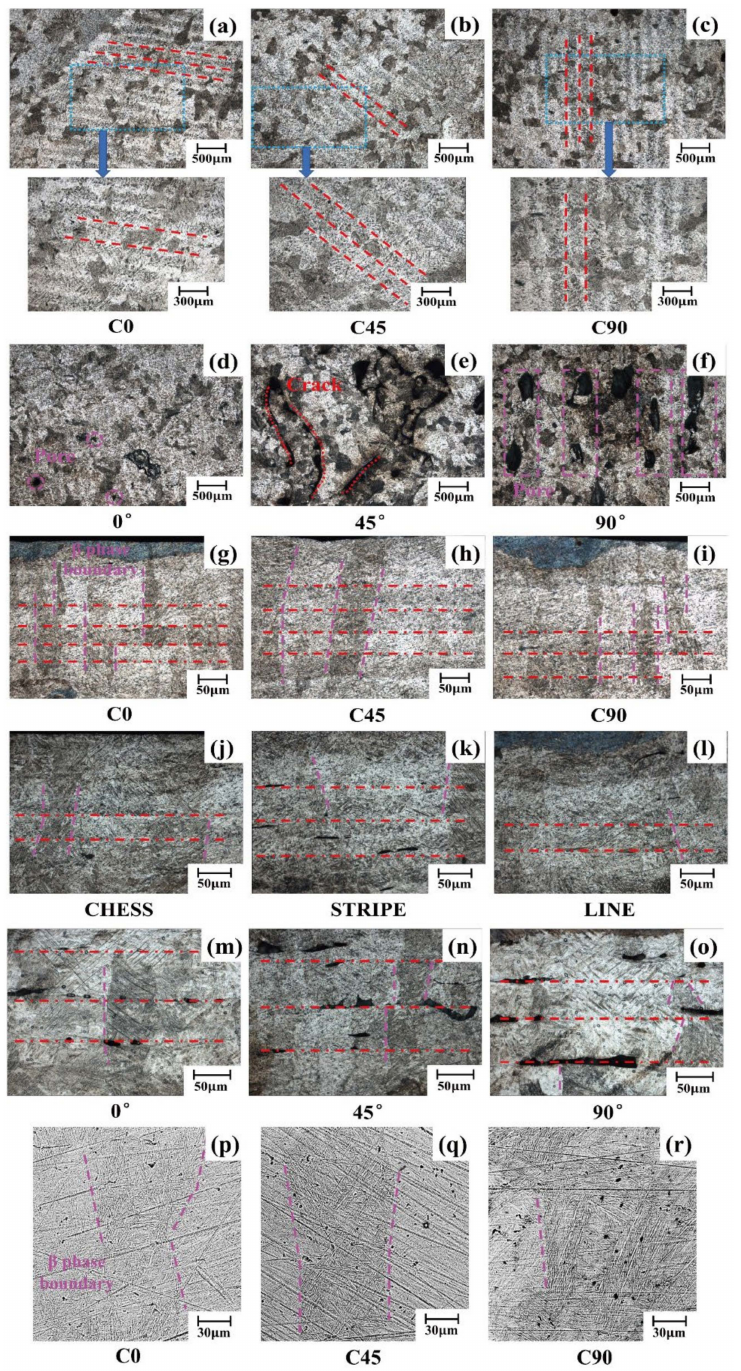
Figure 12. Metallographic structure of L-PBF samples under different combinations of scanning strategies and a single scanning strategy. ( a – f ) Corresponding to the upper-surface metallographic structure of the C0, C45, C90, 0 ◦ , 45 ◦ , and 90 ◦ samples, respectively; ( g – o ) corresponding to the longitudinal-section metallographic structure of C0, C45, C90, CHESS, STRIPE, LINE, 0 ◦ , 45 ◦ , and 90 ◦ samples respectively; ( p – r ) SEM images of C0, C45, and C90